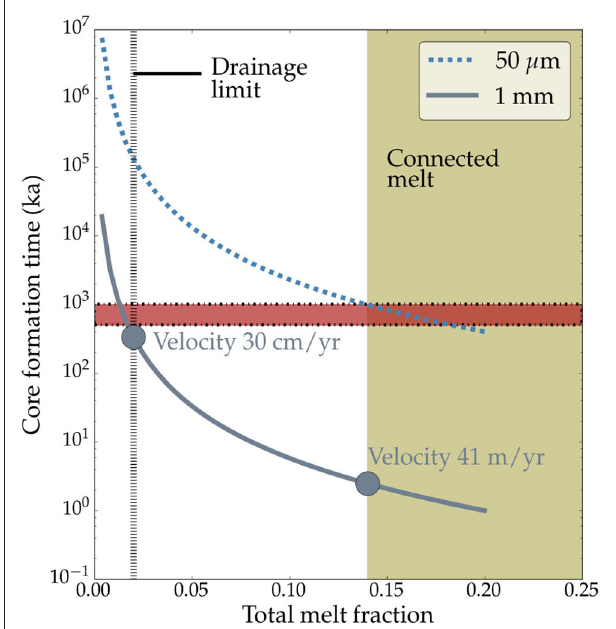
FIGURE 9 | Core formation time in ka, defined as the time taken for a parcel of melt to travel from the surface to the center of a 100 km radius planetesimal, as a function of melt fraction. The legend indicates the grain size used to calculate the two curves. The vertical broken line is the drainage threshold from Ghanbarzadeh et al. (2017) and the horizontal shaded box indicates a time span of 0.5–1 Ma, the cosmochemical constraint on timing of core formation. The melt fractions above the connection threshold is indicated by the shaded region on the right of the plot. The two filled circles represent the time of core seggregation at the connection threshold and the drainage limit, respectively. The percolation velocities of core forming melts at these two values are annotated in the